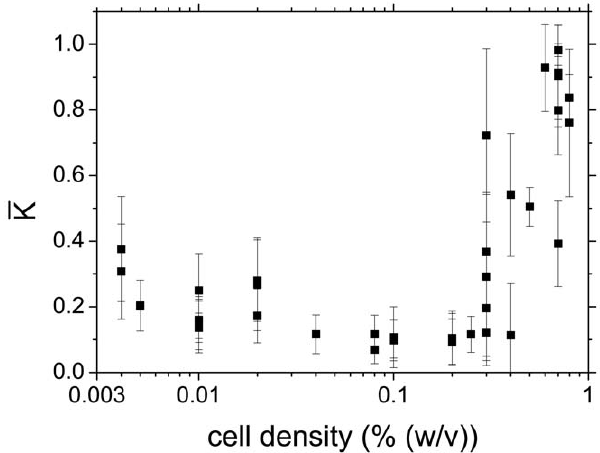
Figure 7. Time-averaged Kuramoto order parameter K for experiments at different cell densities r . At cell densities above 0.3%, K is high indicating coherent oscillatory dynamics of the cells in the population. At cell densities below 0.3% the low value of K shows that the cells oscillate in a decoherent fashion. The critical cell density lies at r crit * 0.3%. The error bars represent the standard deviation s K and provide a measure for the fluctuations of the phase synchronisation in each individual